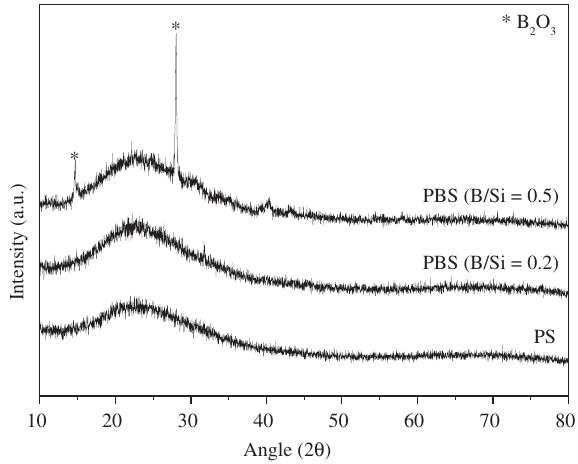
Figure 3. X ray diffraction patterns of PS- and PBS-derived MTES glasses obtained at 1000 °C.